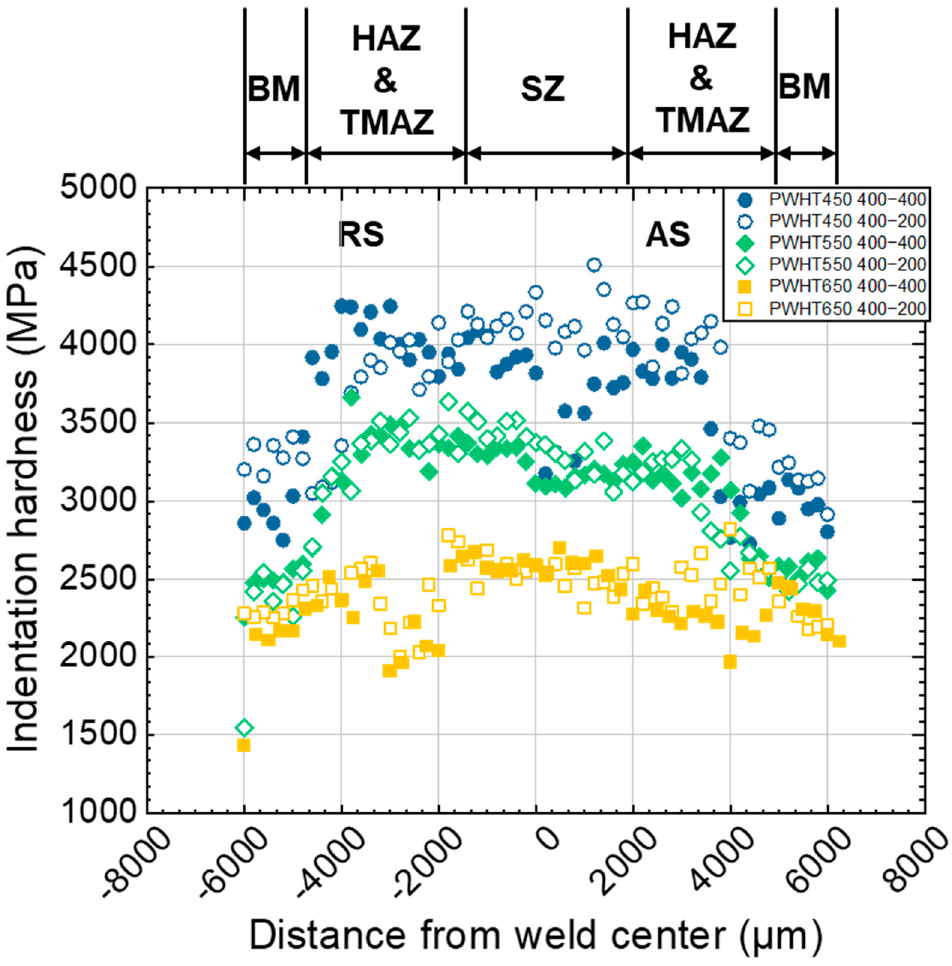
Figure 9. Hardness profiles of the FSWed joint at different annealing temperatures. The section of the joint areas represented above is based on macrostructural observation via OM.